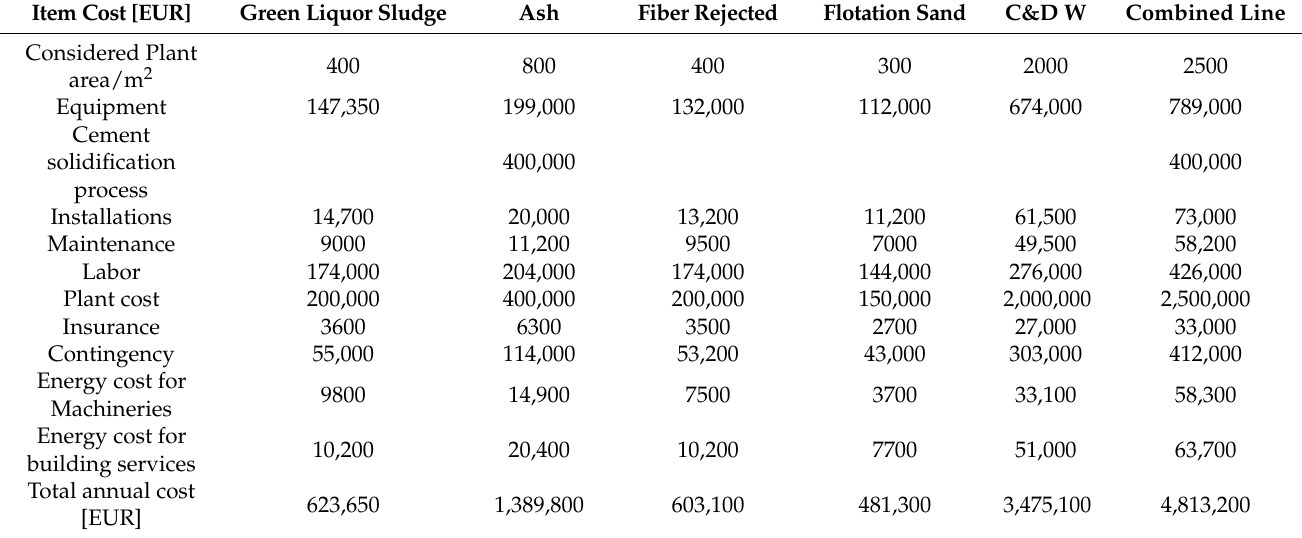
Table 5. Annual investment [EUR] needed for pretreatment of waste materials.